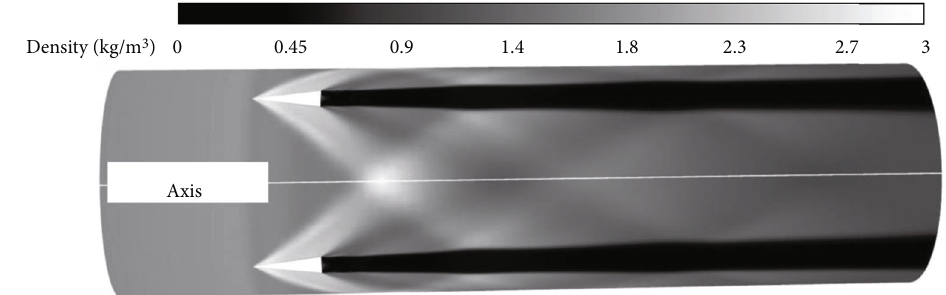
Figure 19: Density distribution of the surface at r = 50mm .